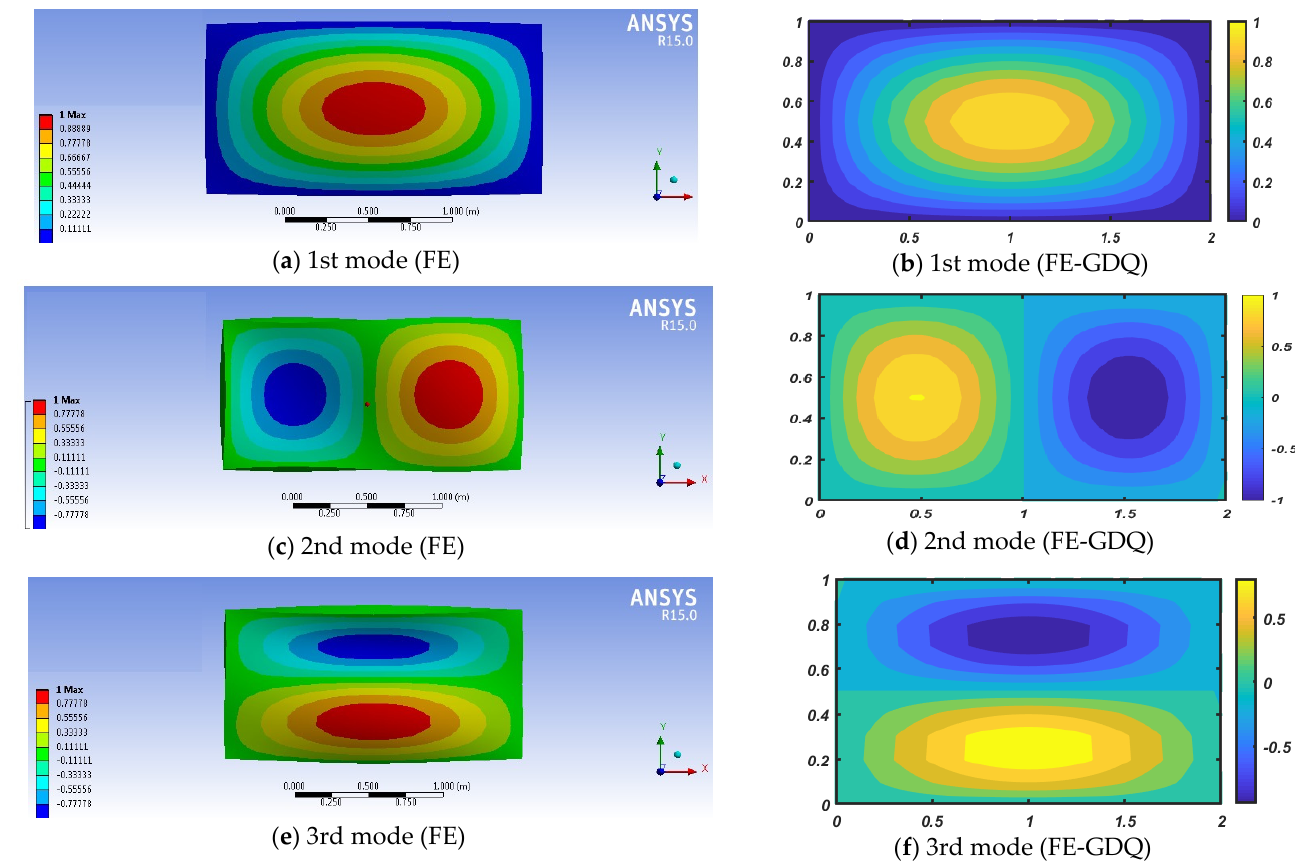
Figure 2. Comparative evaluation of the first three buckling mode shapes for a SSSS homogenous plate under a shear loading condition.